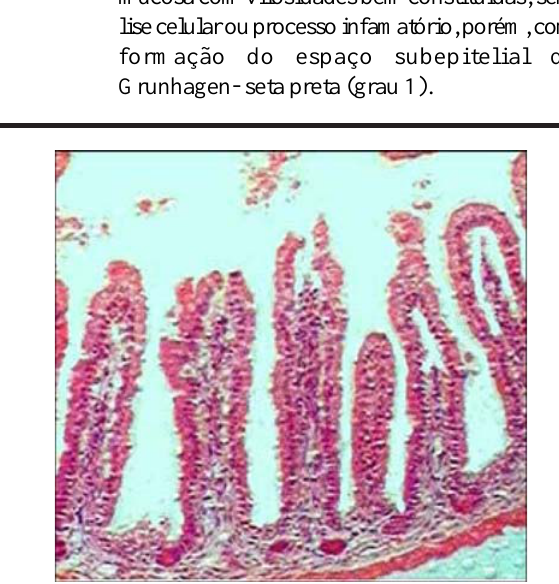
FIGURA 5 - Fotomicrografia de corte histológico de intestino do animal do Grupo H-R mostrando mucosa com destruição estrutural das vilosidades, havendo apenas esboço de algumas, formadas por células inflamatórias e material necrótico, com hemorragia e ulceração glandular basal (grau